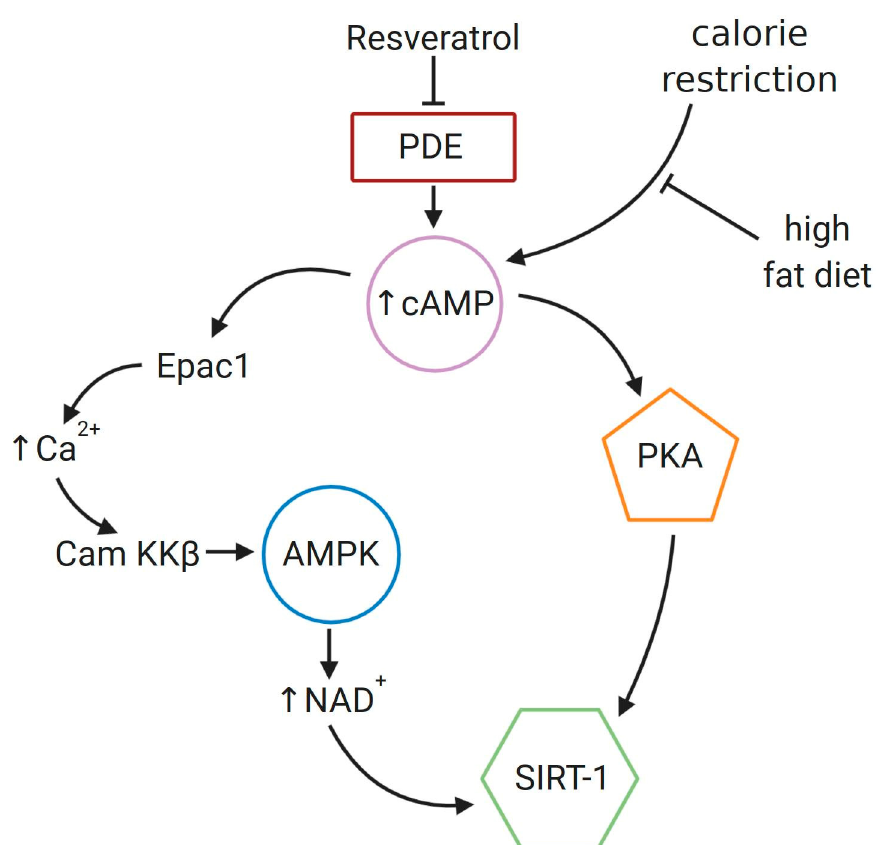
Figure 5. Mechanism of SIRT-1 activation by resveratrol in GCs. Resveratrol inhibits activity of cyclic nucleotides phosphodiesterase (PDE), which results in an increase of 3 ′ ,5 ′ -cyclic adenosine monophosphate (cAMP). In turn, activation of the exchange guanine nucleotide Epac1 occurs, followed by enhanced level of intracellular calcium. Ca 2 + / CaM-dependent protein kinase kinase β (CaMKK β ) activates AMPK through phosphorylation, which causes an increase in the level of NAD + and, in consequence, activation of SIRT-1. The second suggested mechanism of SIRT-1 activation is the phosphorylation by protein kinase PKA, activated by higher cAMP level [91,92].